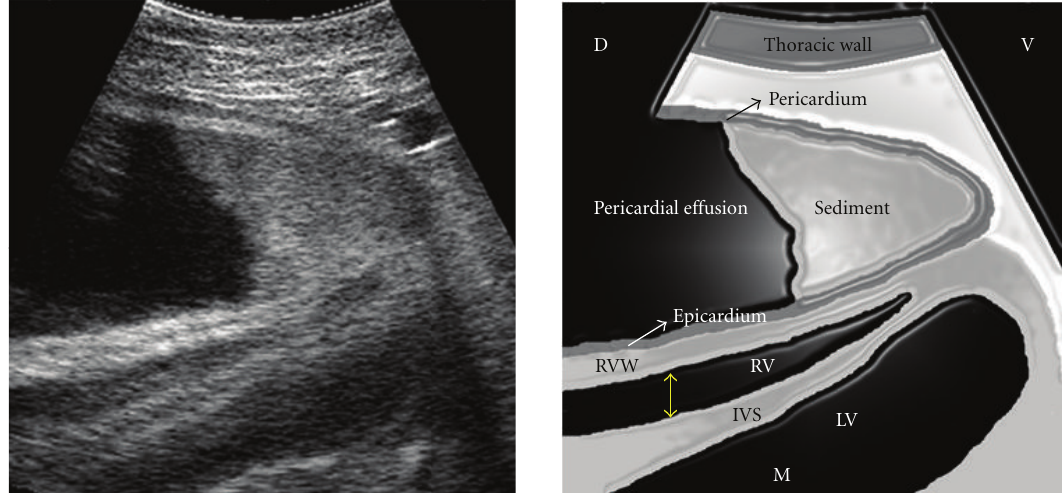
Figure 4: Two-dimensional echocardiogram obtained from right 4th ICS, by placing the transducer parallel to the ribs, depicting anechogenic pericardial e ff usion and echogenic sediment at the apex of pericardial cavity. Notice the compression of the right ventricle. ICS: intercostal space; RVW: right ventricular wall; IVS: interventricular septum; RV: right ventricle; LV: left ventricle; D: dorsal; V: ventral; M: medial.